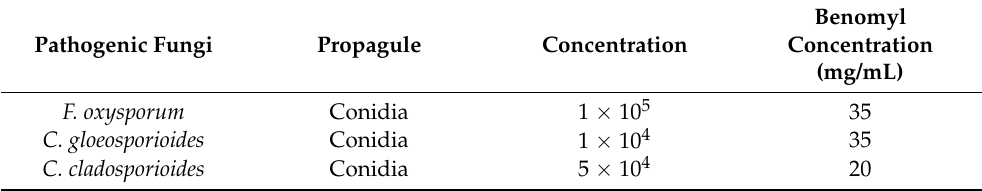
Table 4. Bioassay conditions with the plant pathogenic fungi evaluated.